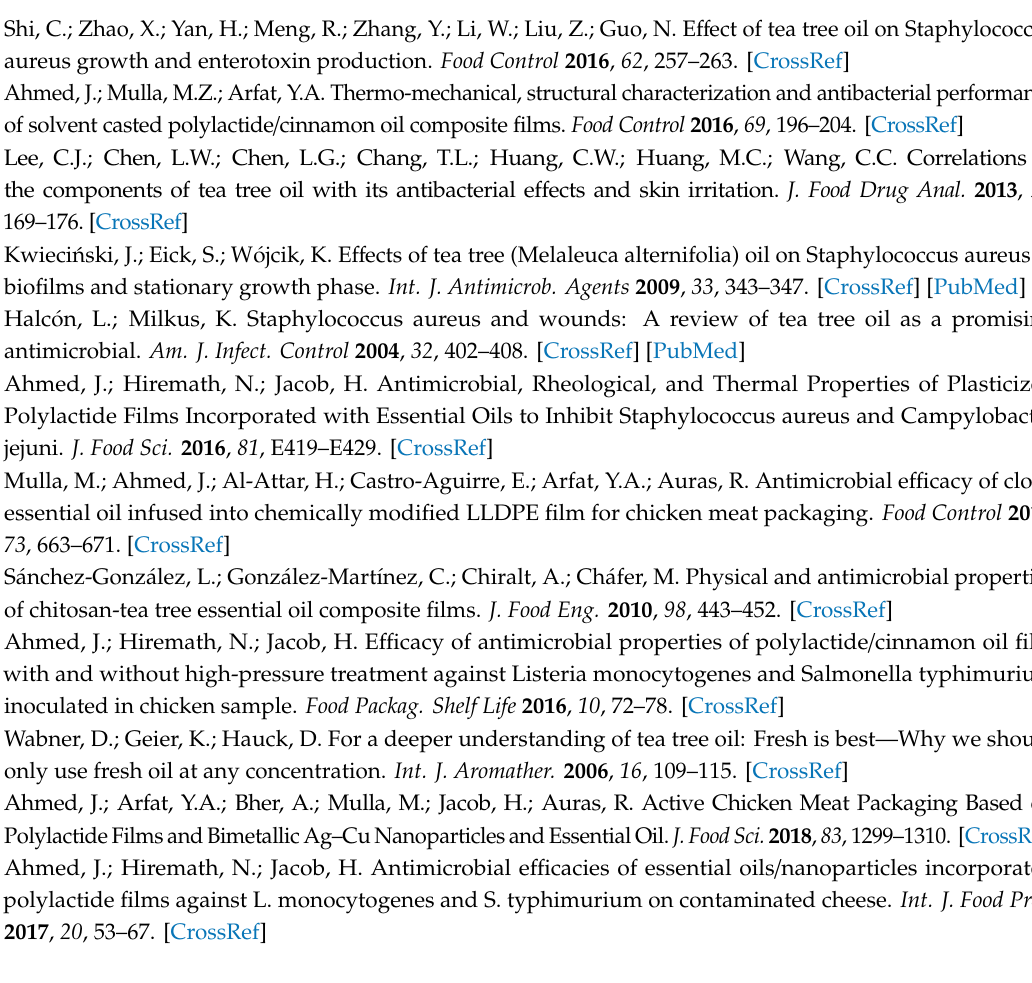
Figure S1: DSC thermograms of studied PLA-based materials. Figure S2: Photos of Bacteria ( E. coli and S. aureus ) growth in direct contact with samples consisted of PLA and TTO. Figure S3: Photos of Bacteria ( E. coli and S. aureus ) growth in direct contact with samples consisted of PLA, PEG and